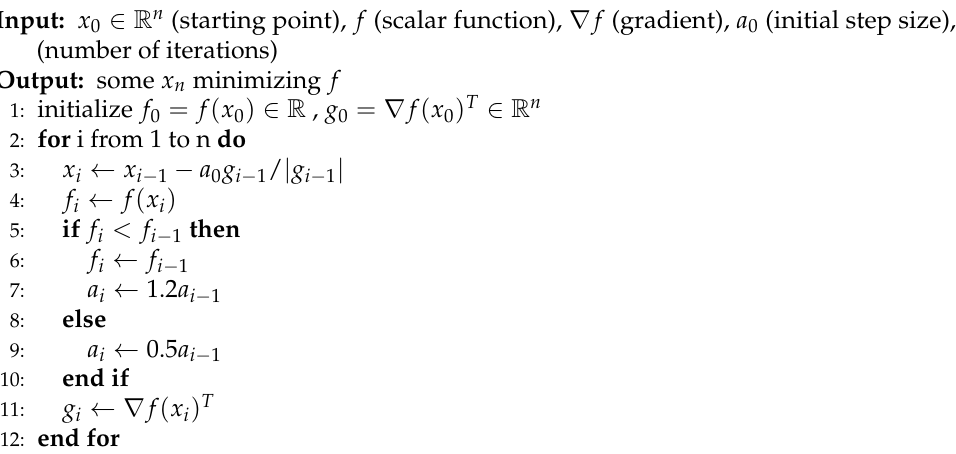
Algorithm 1 Gradient Descent with Step-Size Adaptation